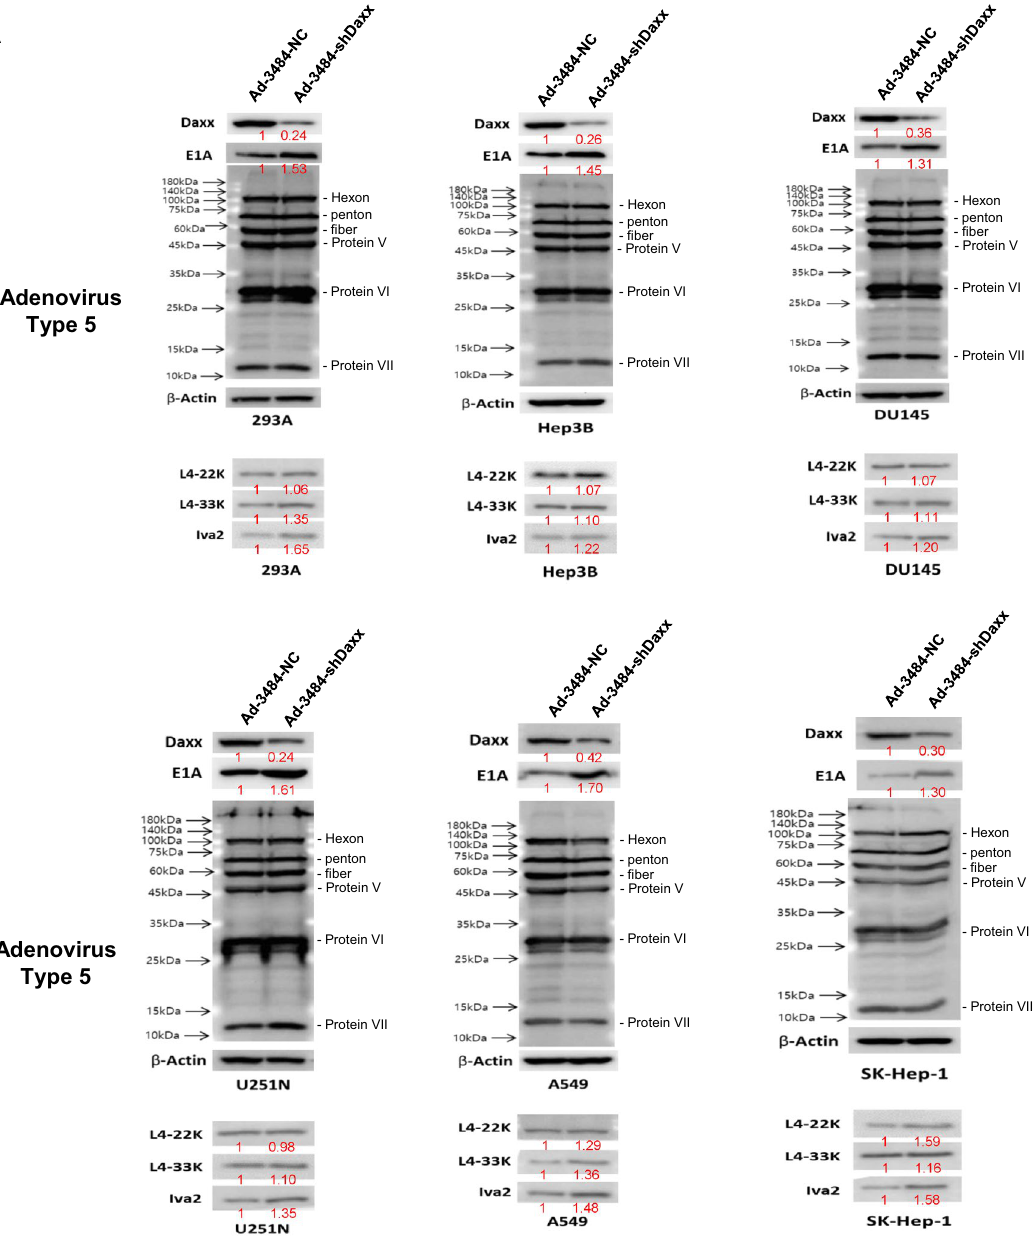
Figure 2. Increased viral infectivity by Daxx downregulation. ( A ) Western blot analysis for the detection of viral late gene products was performed in a variety of cancer cells as well as 293A cells infected with Ad-3484-NC or Ad-3484-shDaxx at 50 MOI for 48 h. The numbers indicate the relative band intensity of Ad-3484-shDaxx to control (Ad-3484-NC) after band intensities were measured with a densitometer. ( B ) Estimation of viral DNA copy number after infection with Ad-3484-shDaxx at 10 MOI for 24 h in 293A cells. After infection for 24 h, cultured cells and media were harvested. Purified DNA (CsCl gradient and Tris-dialysis of virus soup) was measured at OD260 and OD280 for copy-number calculations. Error bars represent standard errors from three independent experiments. P values less than 0.05 were considered statistically significant (* P < 0.05). ( C ) Virus particle estimation. After CsCl gradient and Tris-dialysis purification of the virus soup from 293A cells following infection with the same amount of each oncolytic adenovirus (Ad-3484-NC and Ad-3484-shDaxx), total virus particles (VP/ml) were calculated by measuring absorbance at OD260 (left) and the amounts of infectious virus particles were successfully calculated by TCID50 titration assays in 293A cells using plaque-forming units (PFU/ml) (right). Error bars represent standard errors from three independent experiments. P values less than 0.05 were considered statistically significant (* P < 0.05). ( D ) Infectious viral particles were estimated after transfection of pcDNA3.1-IVa2 followed by oncolytic control adenovirus in various HCC. Error bars represent standard errors from three independent experiments. P values less than 0.05 were considered statistically significant (* P <